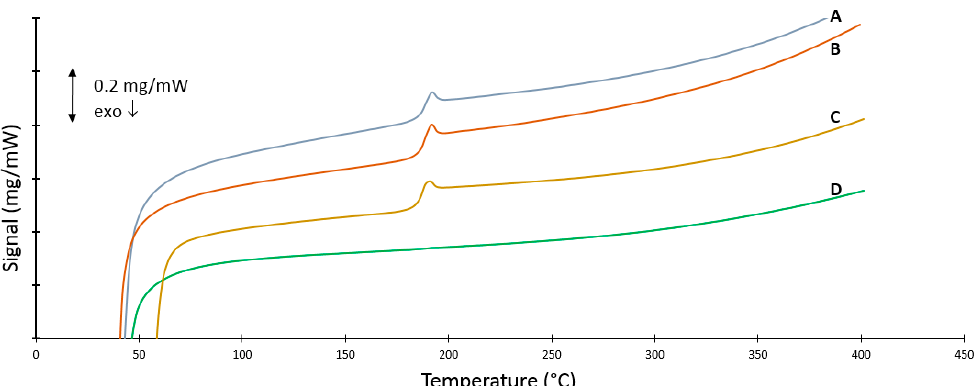
Figure 9. Second heating run of DSC measurements on ( A ) spray-dried powder obtained at best parameter settings, ( B ) rotor milled powder subjected to the three step refinement process with additional sieving at 80 μ m, ( C ) virgin PSU and ( D ) fine powder obtained after 10 min of ball milling the PSU pellets.